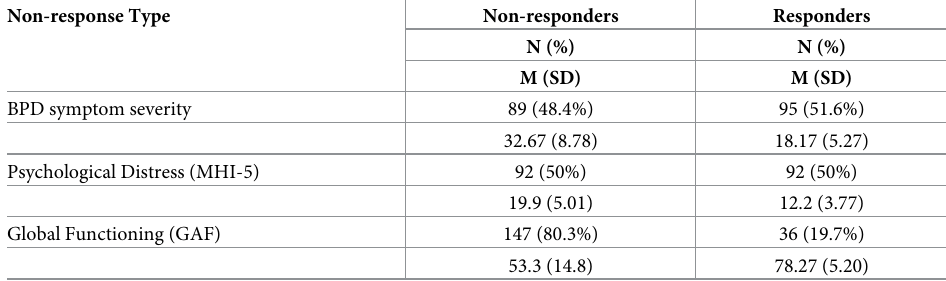
Table 3. Responder and non-responder estimates by Reliable Change Index for BPD symptom severity, psycho- logical distress, and global functioning.